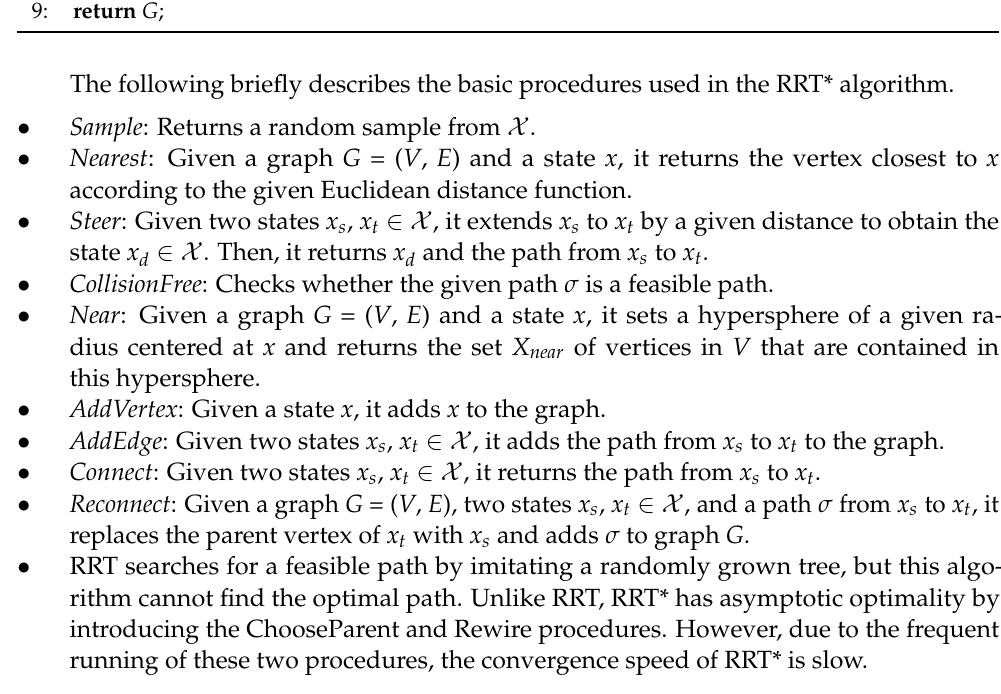
Figure 1. ( a ) ChooseParent (RRT*); ( b ) Rewire (RRT*). (red dot: x new , dashed blue circle: Near ( x new ).) Algorithm 3 Rewire( G , x new , X near